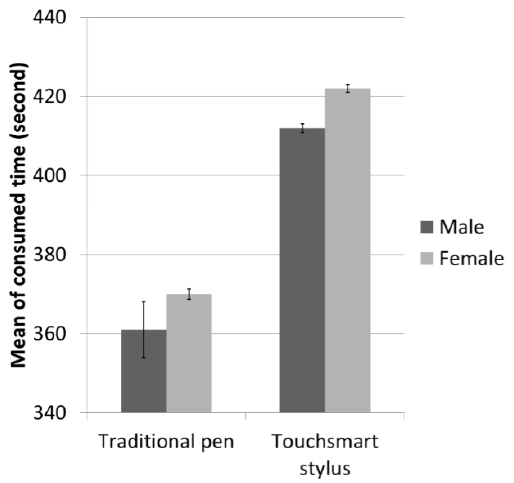
Figure 3. Mean of consumed time in second task (drawing a table).